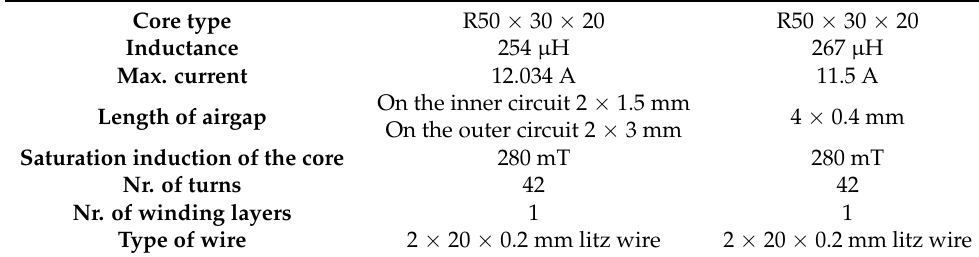
Table 2. Parameters of PFC inductor v2 for analysis of distributed airgap influence.